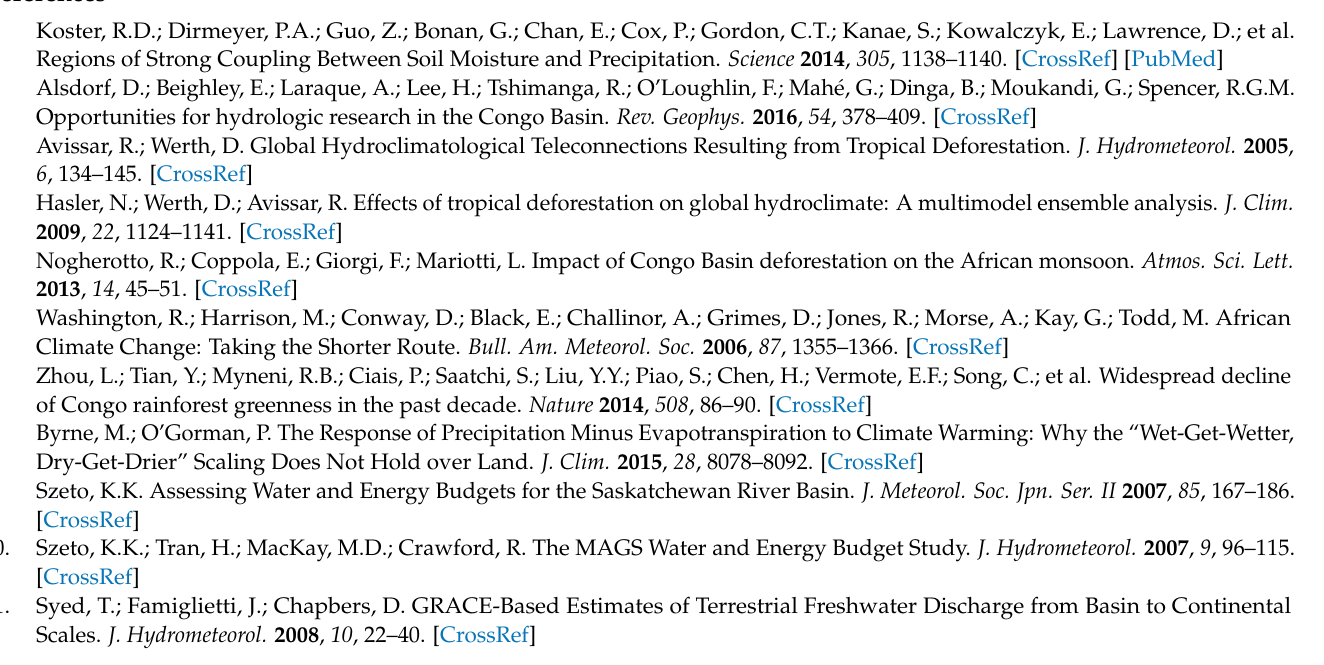
Figure S3: Comparison between DCLS values using a perscribed 0.7 contour and a 0.9 contour for the ( a ) precipitation field, ( b ) evaporation field, an ( c ) the P-E field for the ERA5 dataset over the domain shown in the other figures. Figure S4: Annual mean precipitation (mm/y) from TAMSAT-3 for 2016-2017. Below panel ( a ) are scatter plots comparing TAMSAT-3 precipitation to the ( b ) ERA-I, ( c ) eERA5, ( d ) ERA5, and ( e ) ECOA dataset using common grid points between each of the five datasets. In panels ( b – e ), the red line is the line of best fit, and the blue dotted line represents the 1-to-1 line. Figure S5: ( a ) The decorrelation length scale (km) of the precipitation (left column) and evaporation (right column) from the ERA5 over three different time spans to show covergence of results using only a tw-year window. ( b ) The decorrelation length scale (km) of the P-E field from the ERA5 over three different time spans to show covergence of results using only a tw-year window. Figure S6: An example of the DCLS calculation of evaportaion field for the the ( a ) ERA-I; ( b ) EERA5; ( c ) ERA5; and ( d ) ECOA datasets from 2016-2017. The background color represents the correlation coefficient values, and the black contour represents the 0.9 contour level and the red contour represents the 0.7 contour level. Figure S7: An example of the DCLS calculation of the precipitation field for the the ( a ) ERA-I; ( b ) EERA5; ( c ) ERA5; and ( d ) ECOA datasets from 2016-2017. The background color represents the correlation coefficient values, and the black contour represents the 0.9 contour level and the red contour represents the 0.7 contour